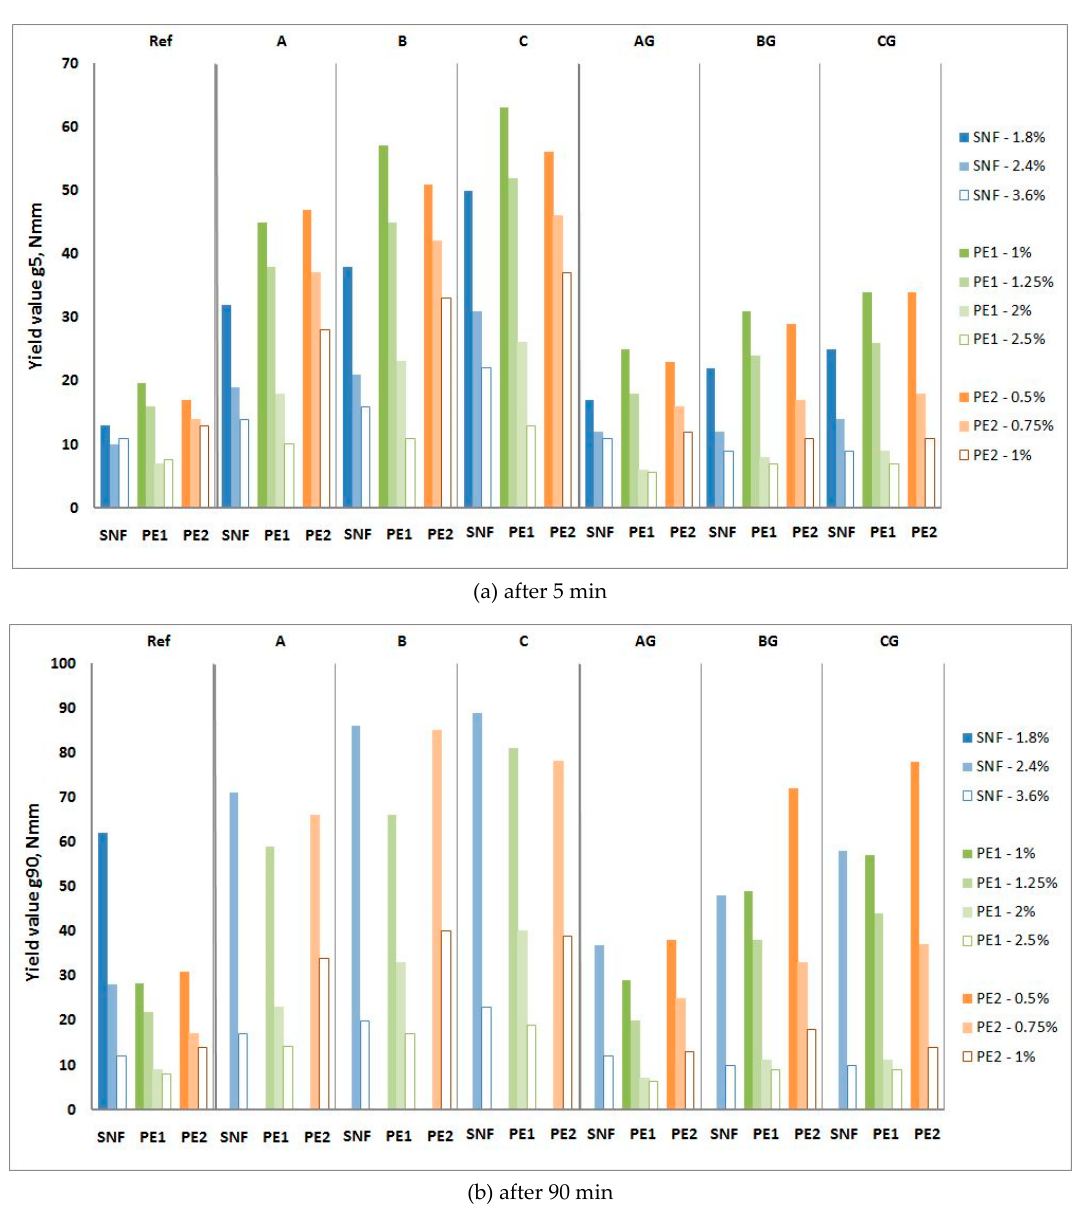
Figure 12. Influence of SNF, PE1 and PE2 on yield value g of mortars with raw and ground CFA. ( a ) after 5 min; ( b ) after 90 min.